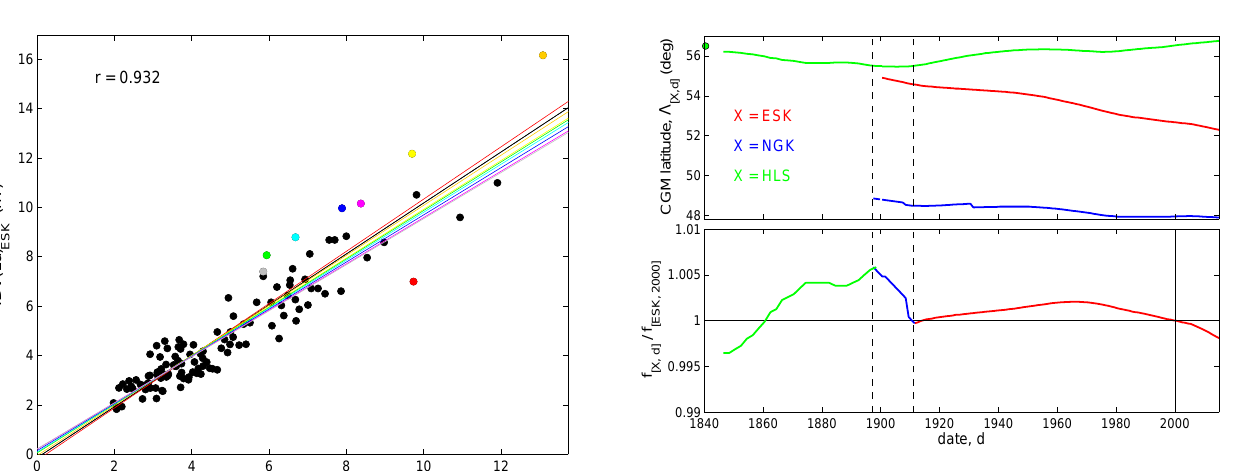
Fig. 10. (Top) The variation of the corrected geomagnetic latitude of ESK (red), NGK (blue) and HLS (green) as a function of date, d . After 1900 values are from the IGRF model (Finlay et al., 2010); before then they are from the gufm1 model (Jackson et al., 2000) with a smooth transition in value and slope implemented over 1890– 1900. The green point is the estimate of 3 [ HLS , 1840 ] of 56.50 ◦ from Nevanlinna (2006). The small discontinuities in the 3 [ NGK ] curve at 1907 and 1931 arise from the moves of the NGK station from Potsdam to Seddin and from Seddin to Niemegk. The blue curve has been extrapolated back to 1897 from 1900 using cubic splines on 3 [ NGK ] for the Seddin site (used for 1897-1907 in the composite). (Bottom) The composited IDV(1d) correction factor to normalise the composite for contributing station ( X ) on a given date ( d ) to ESK in the year 2000, f [ X,d ] /f [ ESK , 2000 ]